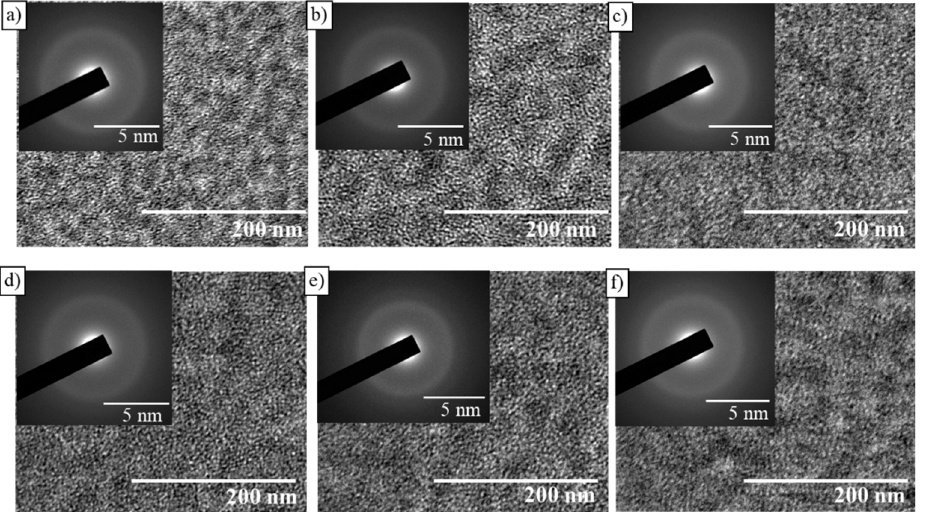
Figure 8. TEM images and electron-diffraction patterns of the Mo-Zr-Si-B coating deposited by HIPIMS (50 Hz) at temperatures 20 ( a ), 200 ( b ), 400 ( c ), 600 ( d ), 800 ( e ) and 1000 °C ( f ).